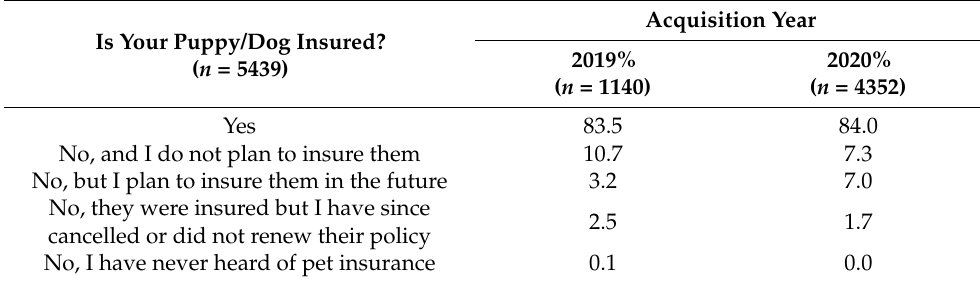
Table 5. Insurance status of 2019 puppies ( n = 1140) and Pandemic Puppies ( n = 4352) as reported by owners at the time of the survey in response to the question “Is your puppy/dog insured”. The answer options listed represent all the choices available to